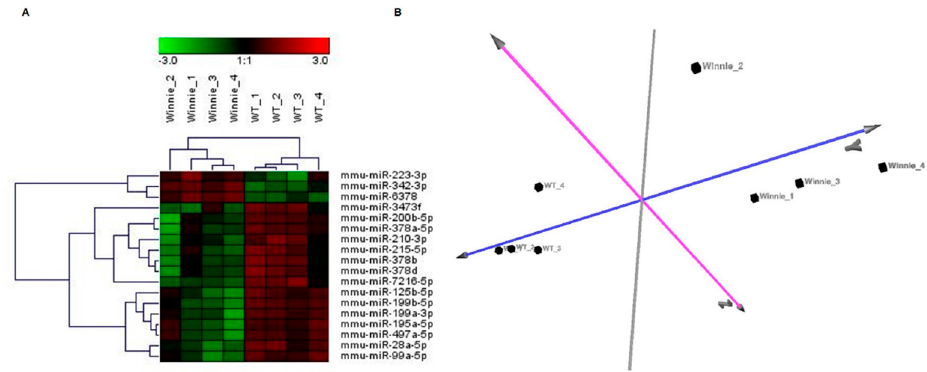
Figure 1. miRNA expression profile of colonic epithelial cells from Winnie and wild-type mice. ( A ) Hierarchical clustering using the 18 differentially expressed miRNAs (FDR < 0.05 and fold change threshold >2) discriminating colonic epithelial cells from Winnie mice compared to wild-type mice. Two principal clusters were identified on the basis of differential miRNA expression. ( B ) PCA based on the expression of differentially expressed miRNA in all samples. PCA showed evident